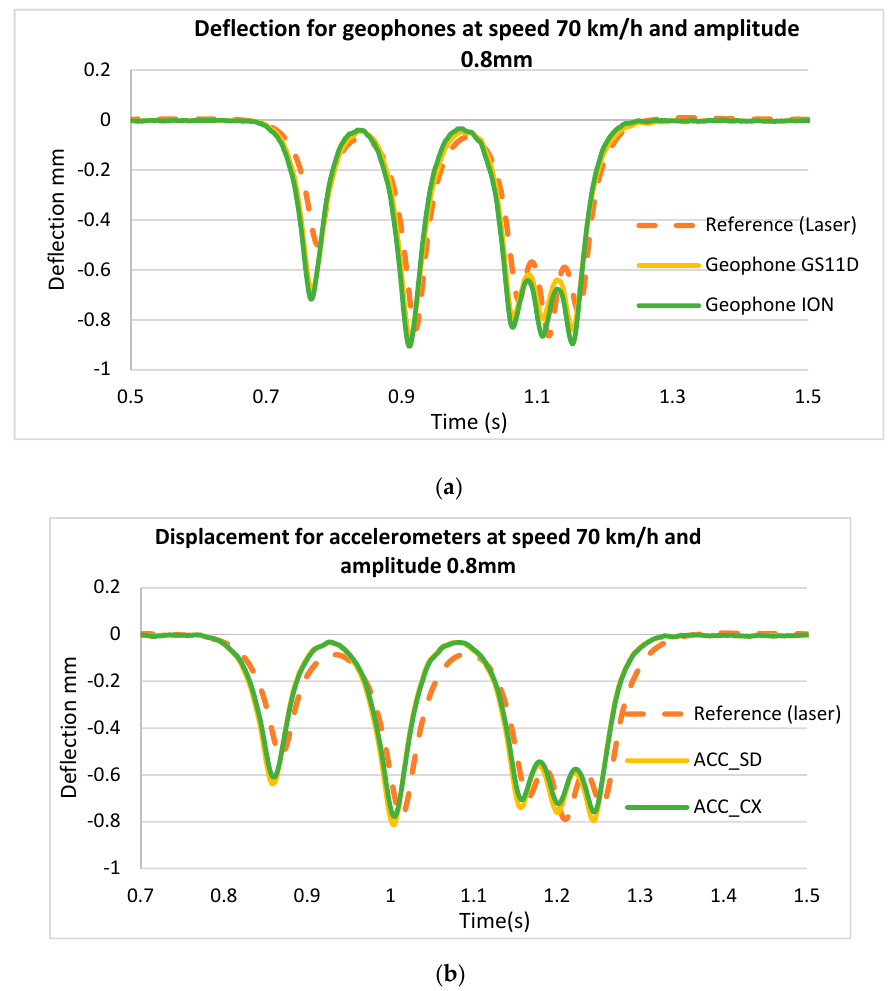
Figure 10. ( a ): Displacement measurements with geophones at a speed of 70 km/h and amplitude of 0.8 mm. ( b ): Displacement measurements with accelerometers at a speed of 70 km/h and amplitude of 0.8 mm.